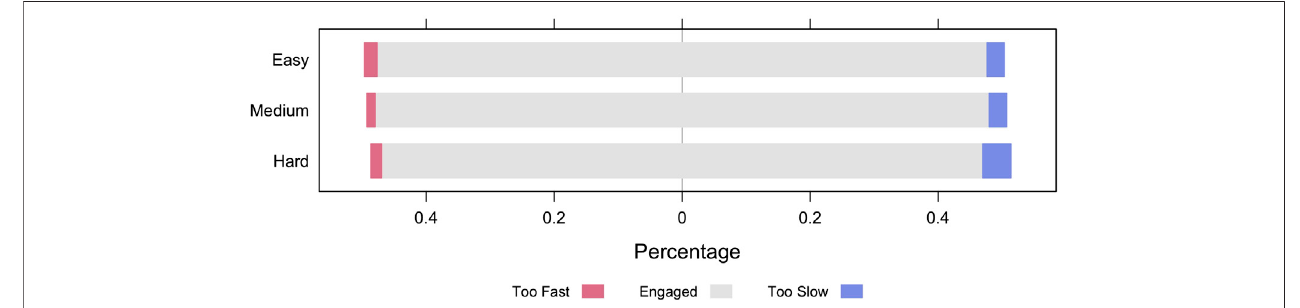
FIGURE 4 | Disengagement rate (Too Fast: fast-disengaged; Too Slow: slow-disengaged) for questions of different dif fi culty levels.